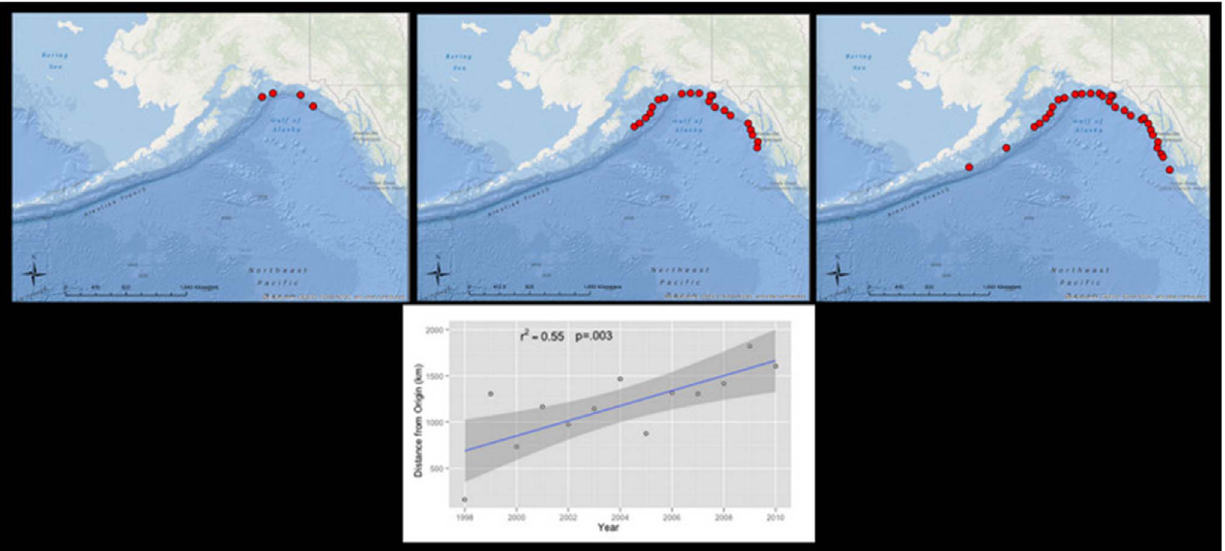
Figure 3. Spatial radiation of depredation and Wave-of-Advance model shows a positive correlation between time and the distance of new observations of depredation from origin (r 2 =.55, p-value =0.003). Red dots represent stations to observe depredation. The panels, from left to right represent 1998, 1998–2003, and 1998–2010. The speed at which the behavior radiated is the slope of solid blue line, or 81.3 6 42.6 km/year (95% confidence interval). The solid blue line represents regression line and the gray shaded area is the 95% confidence interval for the line of best fit.